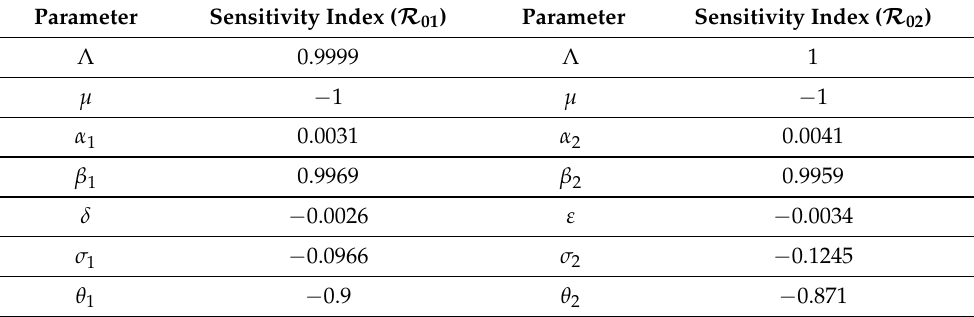
Table 3. The sensitivity index of the parameters.